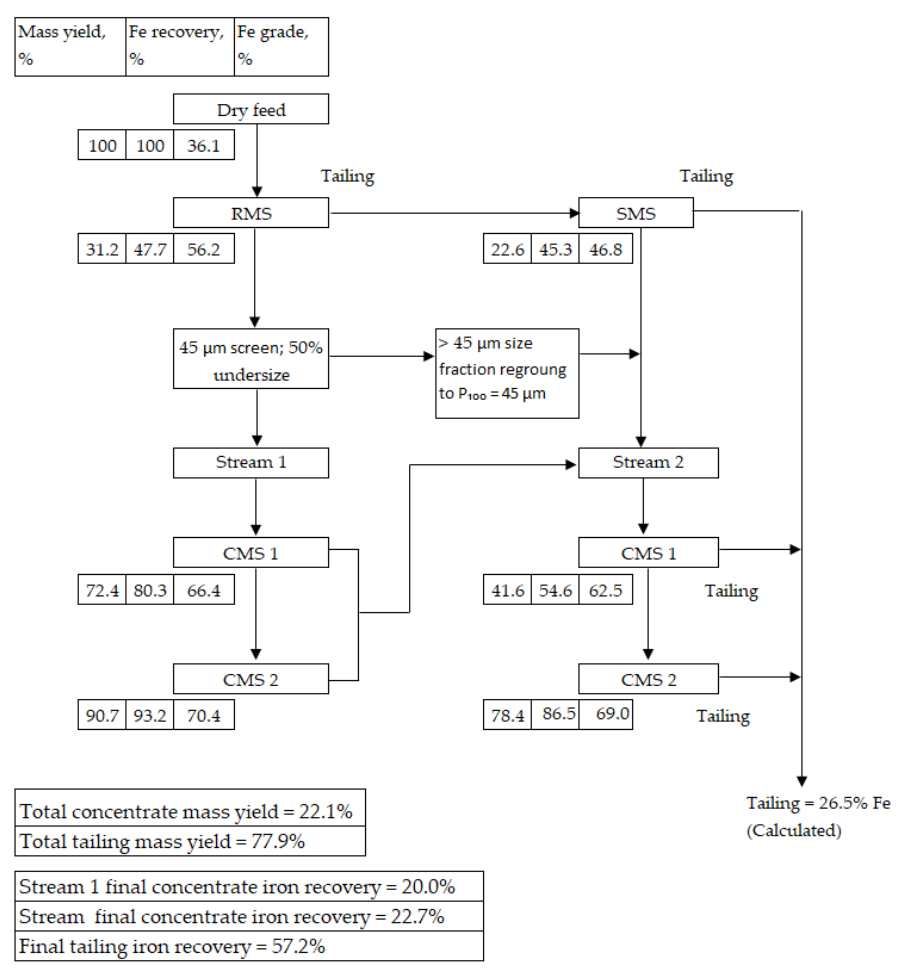
Figure 8. Metallurgical balance for Flowsheet 2 with a feed particle size of P 80 = 75 μm.